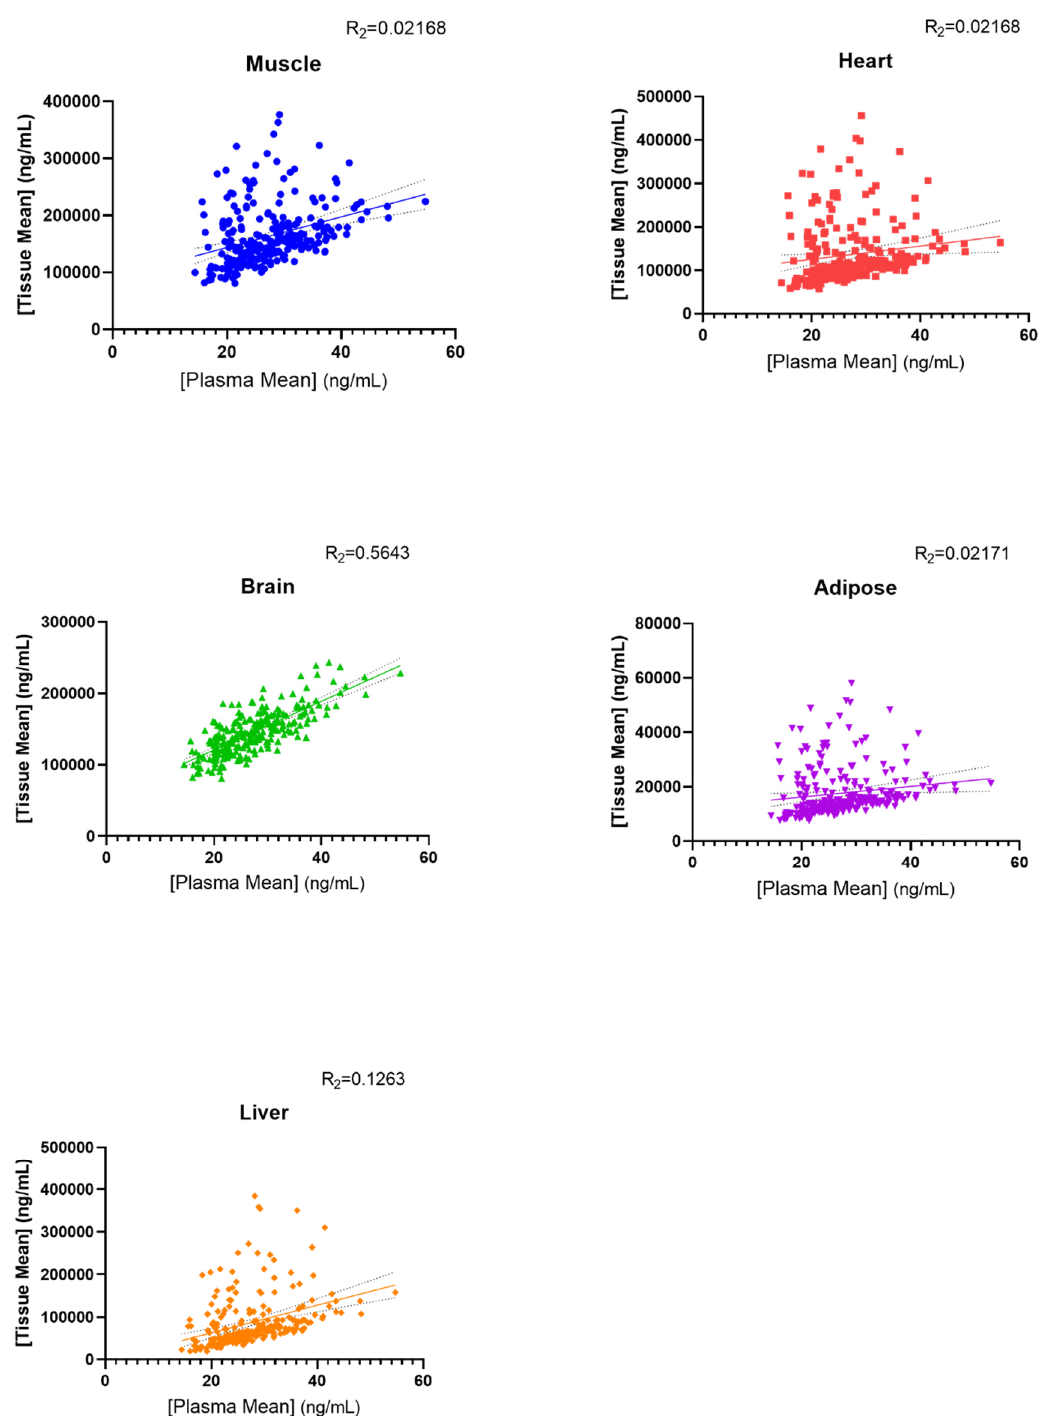
Figure 5. Linear regression analysis evaluating the relationship between simulated maximum epi- rubicin tissue and plasma concentrations in a Sim-Cancer cohort following a single 50 mg/m 2 dose.